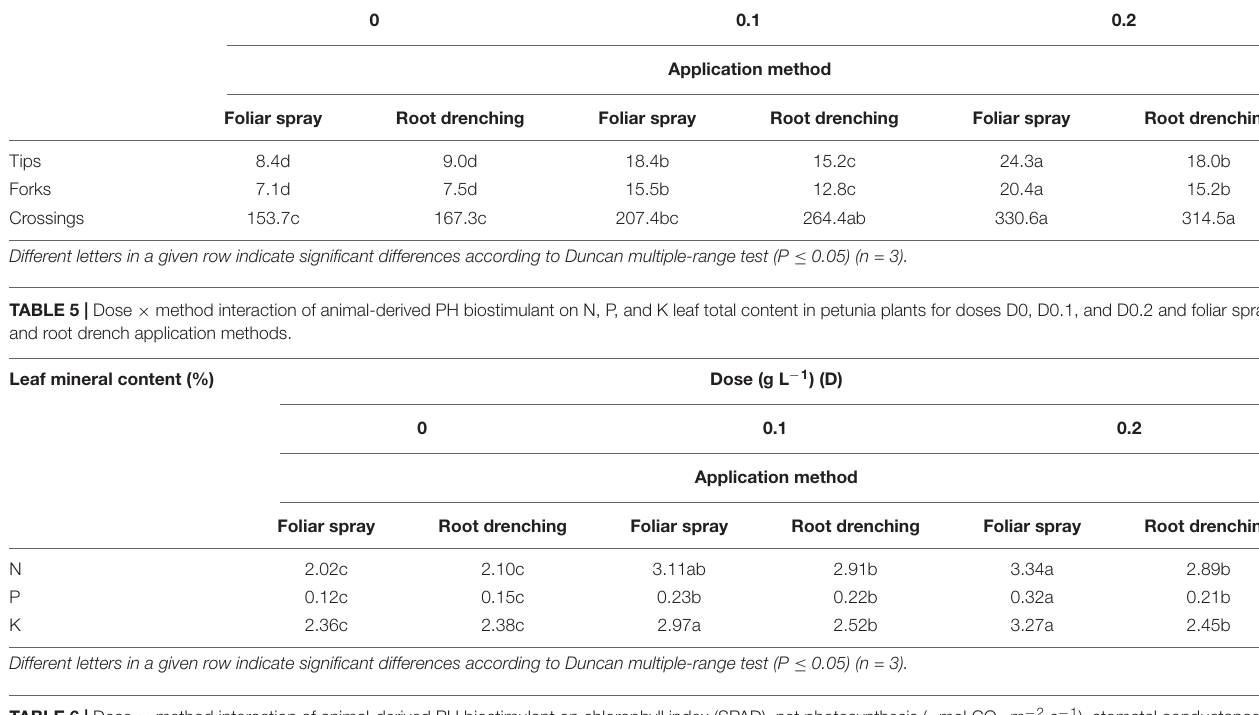
TABLE 4 | Dose × method interaction of animal-derived PH biostimulant on root tips (n 10 3 /plant), forks (n 10 3 /plant), and crossings (n 10 3 /plant) in petunia plants for doses D0, D0.1, and D0.2 and foliar spray and root drench application methods. Root parameters